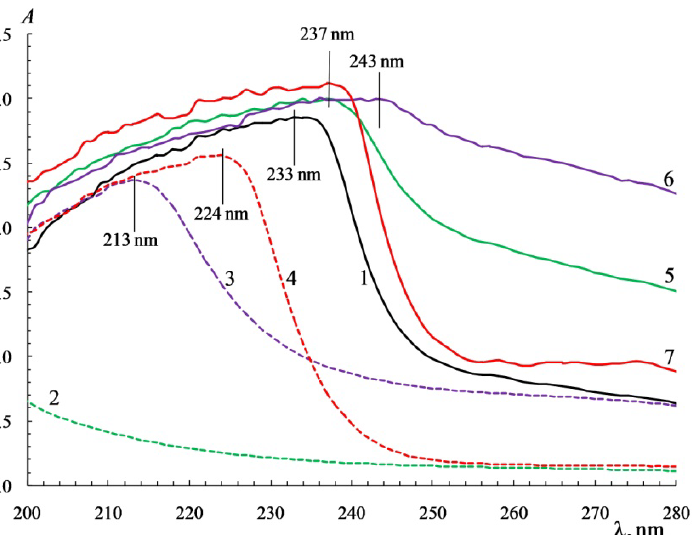
Figure 2. UV absorption spectra for native solutions of gelatin ( C G = 1.0 wt %) (1), κ -carrageenan ( C C = 0.5 wt %) (2), sodium alginate ( C SA = 0.5 wt %) (3), chitosan ( C Ch = 0.5 wt %) (4), and aqueous mixtures of κ -carrageenan-gelatin (5), sodium alginate-gelatin (6), and chitosan-gelatin (7). Polysaccharide/gelatin w / w ratio Z = 0.5 g polysaccharide/g gelatin, C G = 1.0 wt %, 23 ◦ C. Original